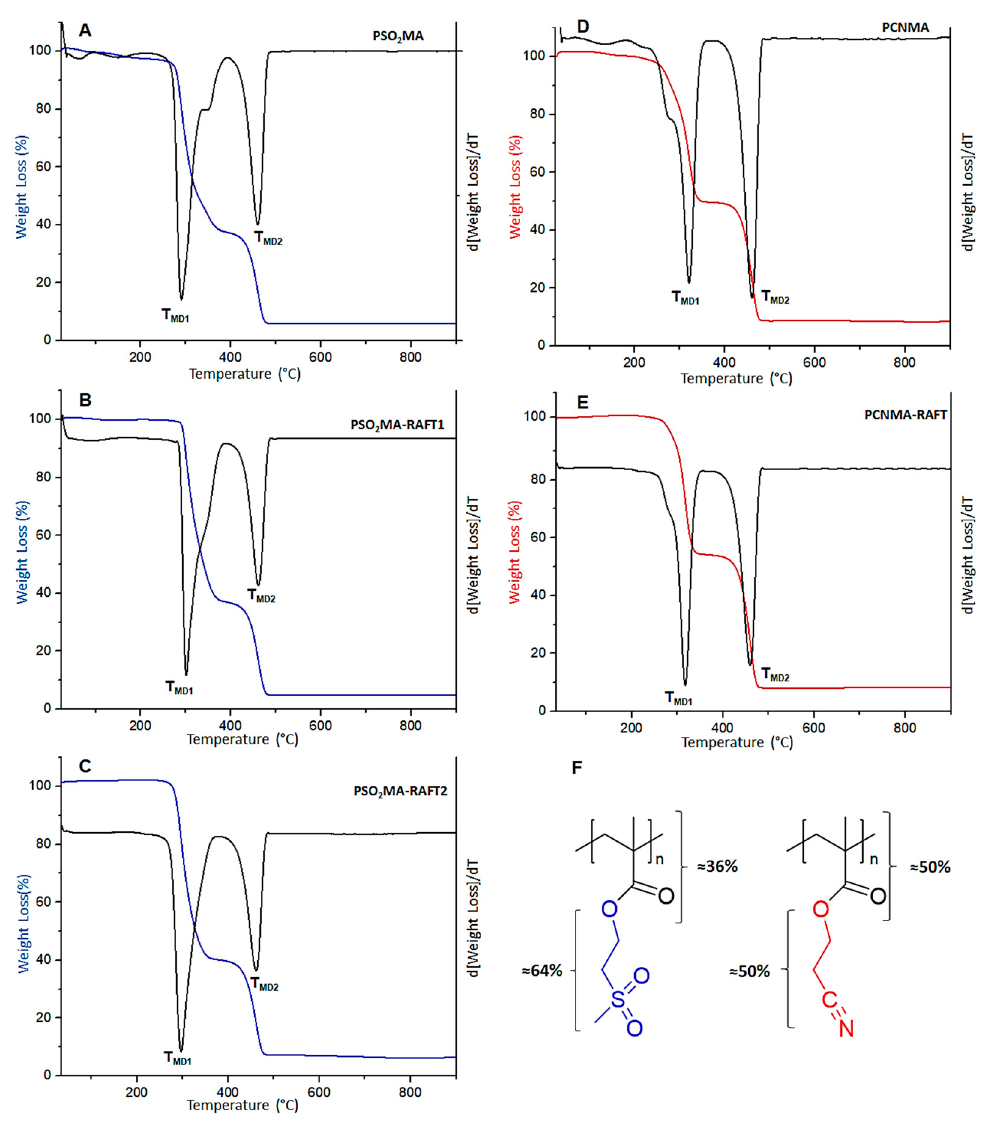
Figure 4. TGA and DTGA thermograms measured for all polymethacrylates containing sulfonyl ( A – C ) and nitrile ( D , E ) functional groups, along with the theoretical mass contribution calculated for their pendant groups and main chains ( F ).